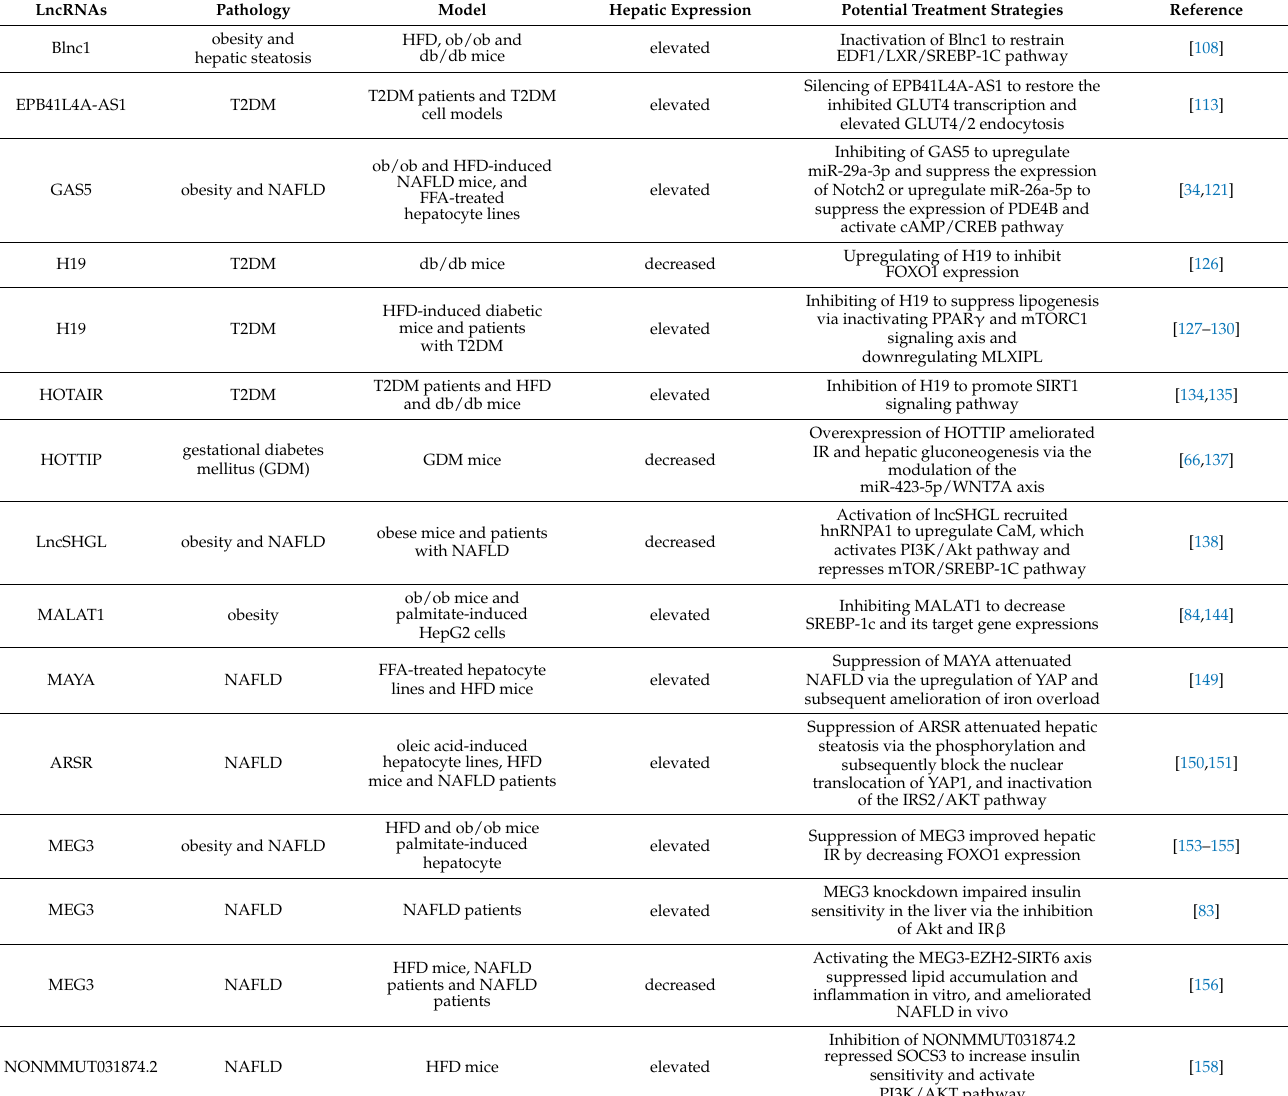
Table 1. LncRNAs in hepatic IR and related